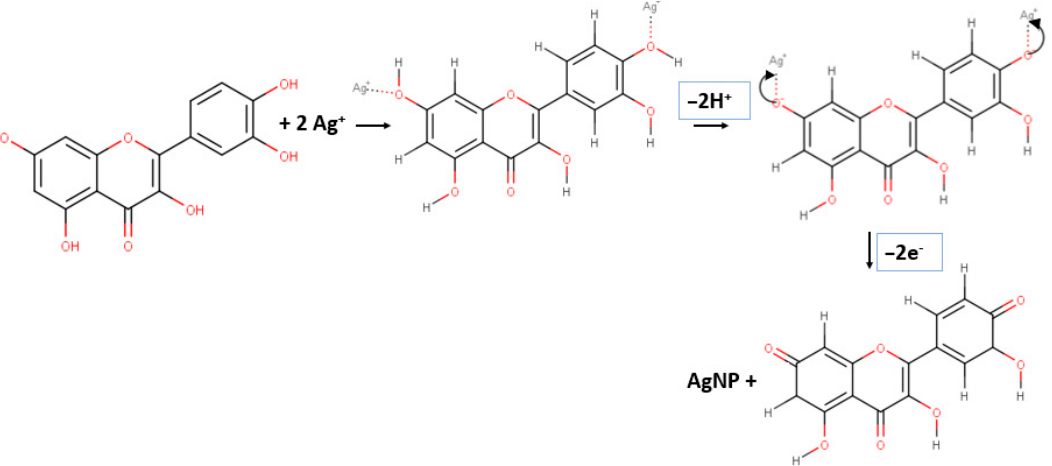
Figure 2. A possible reaction mechanism for silver nanoparticles in the presence of plant extract of Kepok ( Musa paradisiaca L.) banana peel.